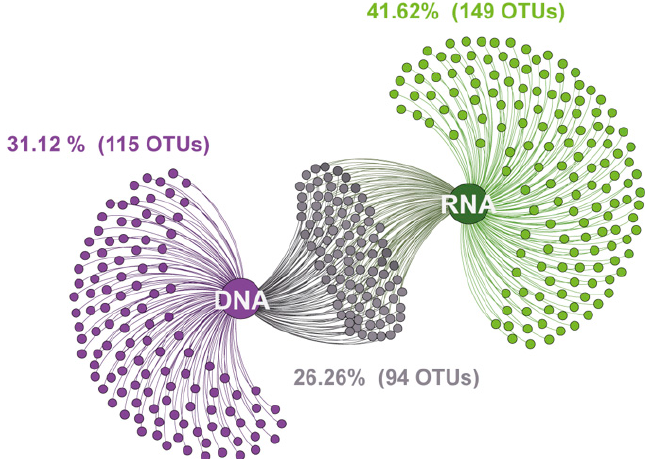
Figure 2. A graphical illustration showing 358 fungal OTUs detected in DNA- and RNA-derived 225 communities from subsurface aquatic habitat. Distinct clusters show fungal OTUs exclusively present 226 in DNA (purple) and RNA (green) derived communities and the OTUs shared (grey) between the 227 two communities. 228